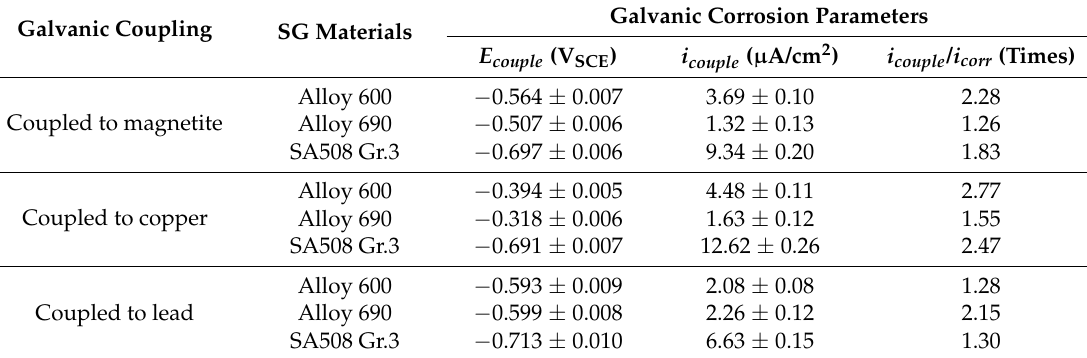
Figure 9. Calculated anodic curves of the SG materials and galvanic corrosion behavior between the SG materials (calculated anodic curves) and the corrosion products (cathodic polarization curves) in alkaline solution at 80 °C. Table 6. Measured values of galvanic corrosion potential E coupled and galvanic corrosion current density i coupled of SG materials coupled to corrosion products obtained from the measured cathodic and calculated anodic polarization curves by using mixed potential theory (AR =